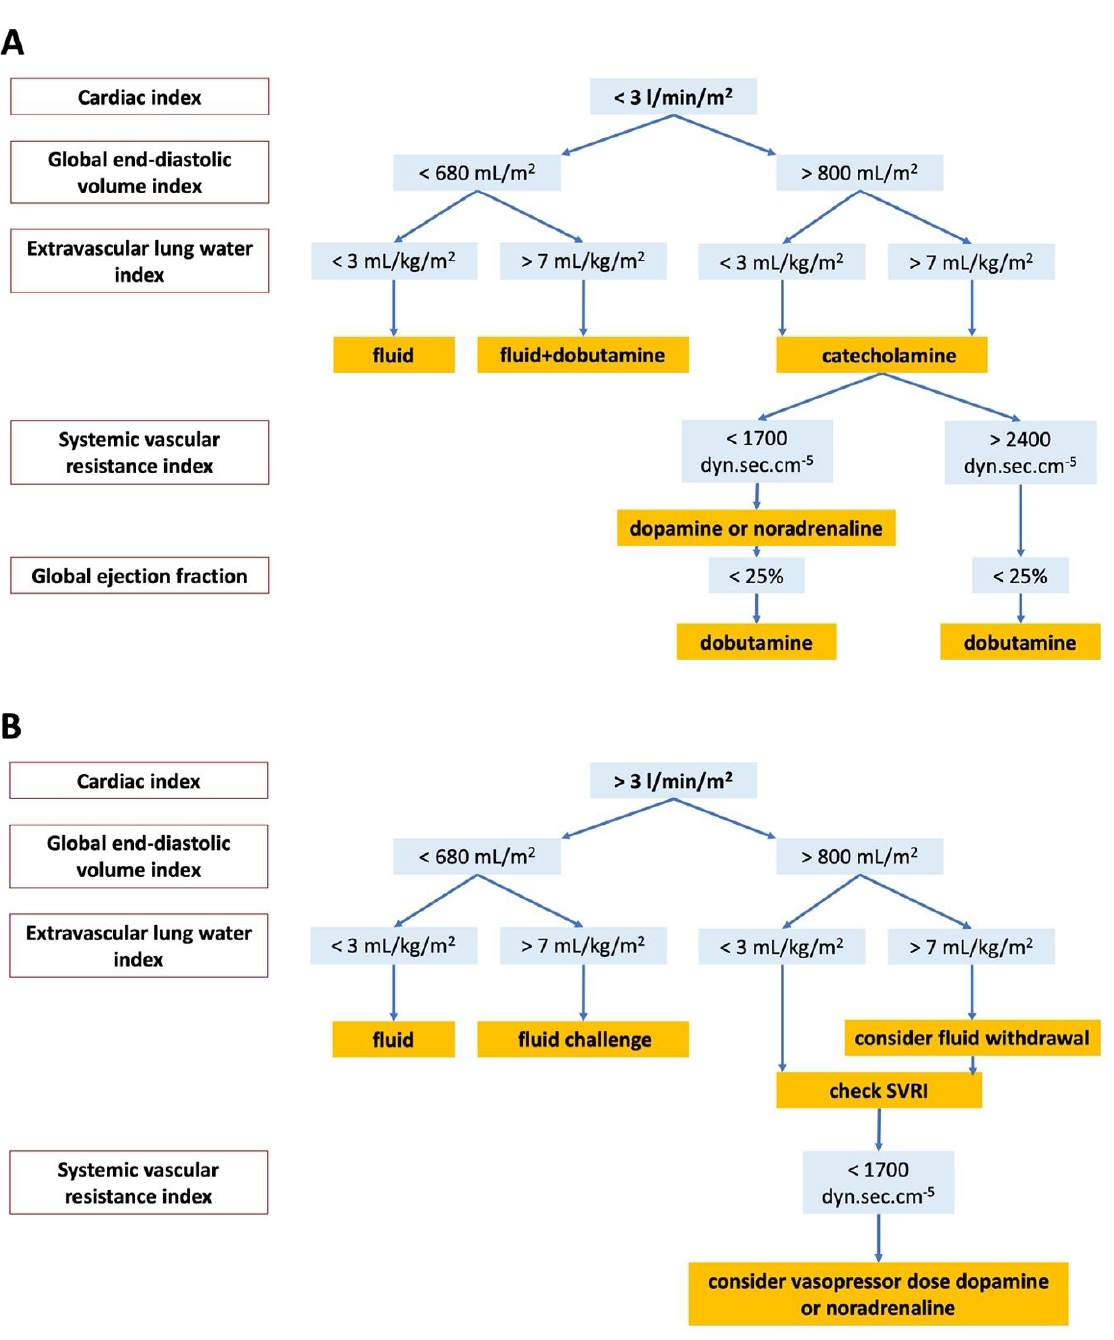
Figure 2. ( A ). Hemodynamic management of patients in PiCCO™ group in the case of low (<3 L/min/m 2 ) cardiac index. ( B ). Hemodynamic management of patients in PiCCO™ group in the case of normal or high (>3 L/min/m 2 ) cardiac index. SVRI: systemic vascular resistance index.